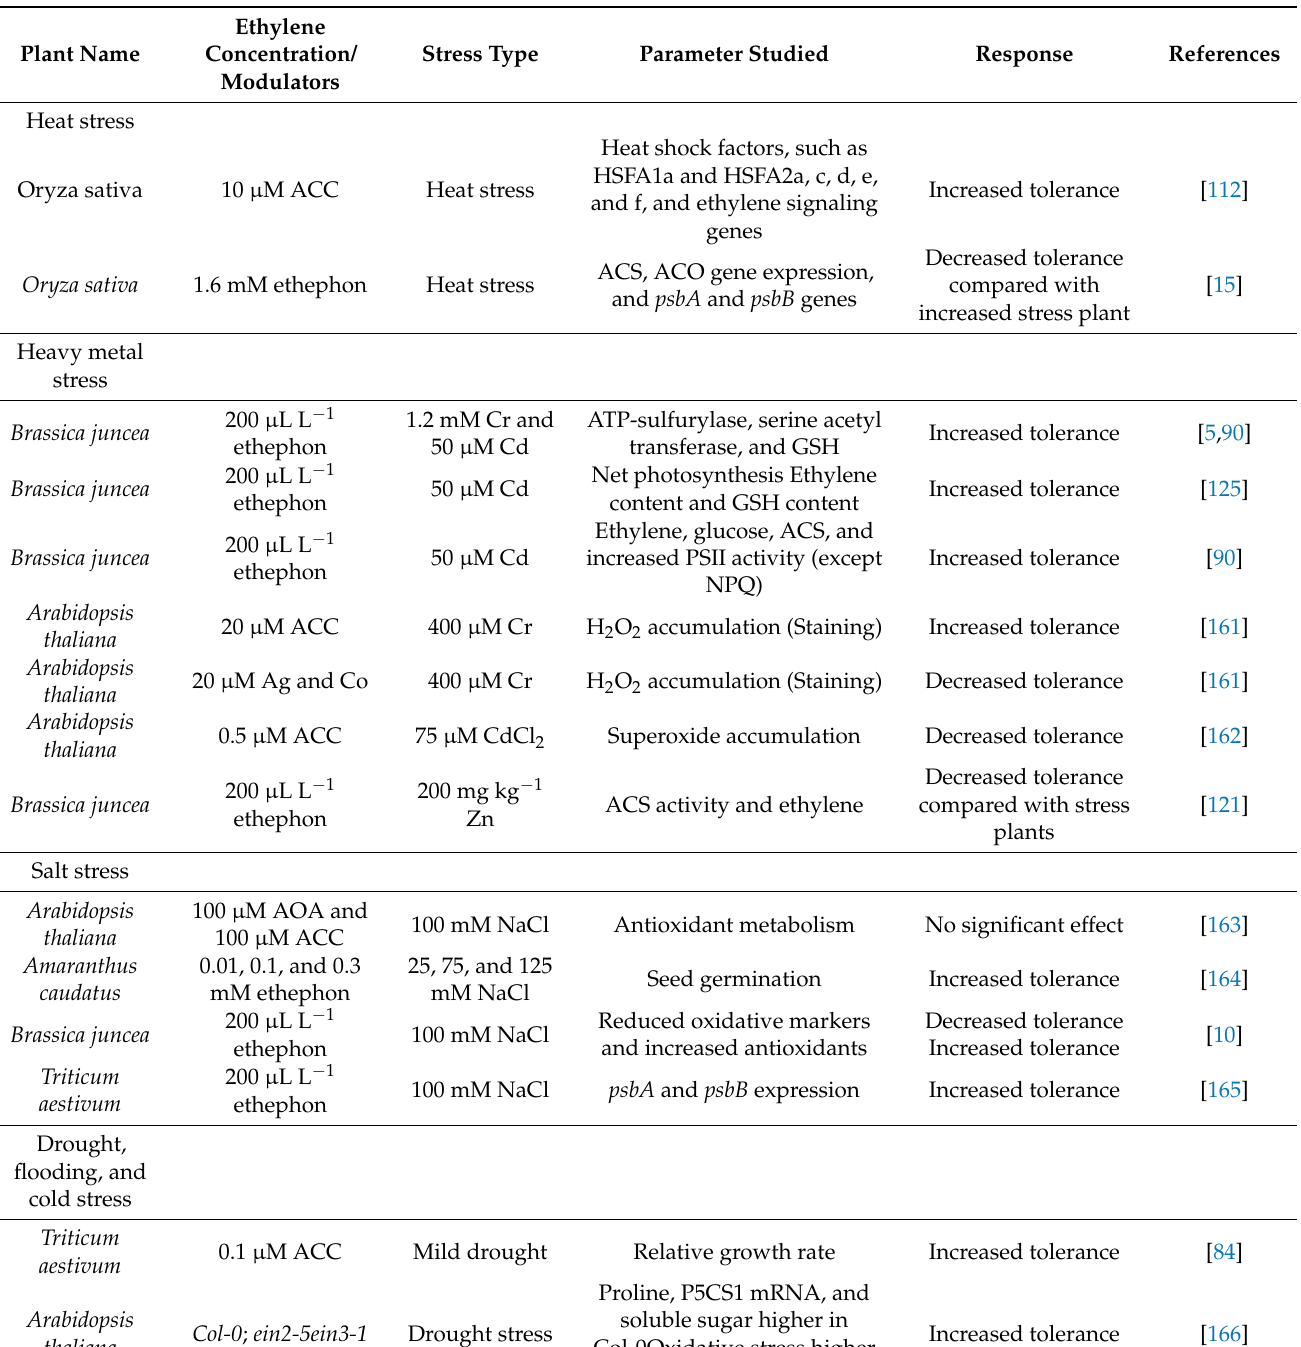
Table 1. Selected studies on the response of plants to ethylene modulators under different environ- mental